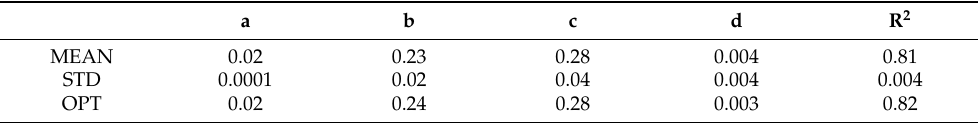
Table 3. The optimal coefficients are selected after the regression analysis. Mean is the mean value of each coefficient, STD is the standard deviation, and OPT is the optimal coefficient solution.